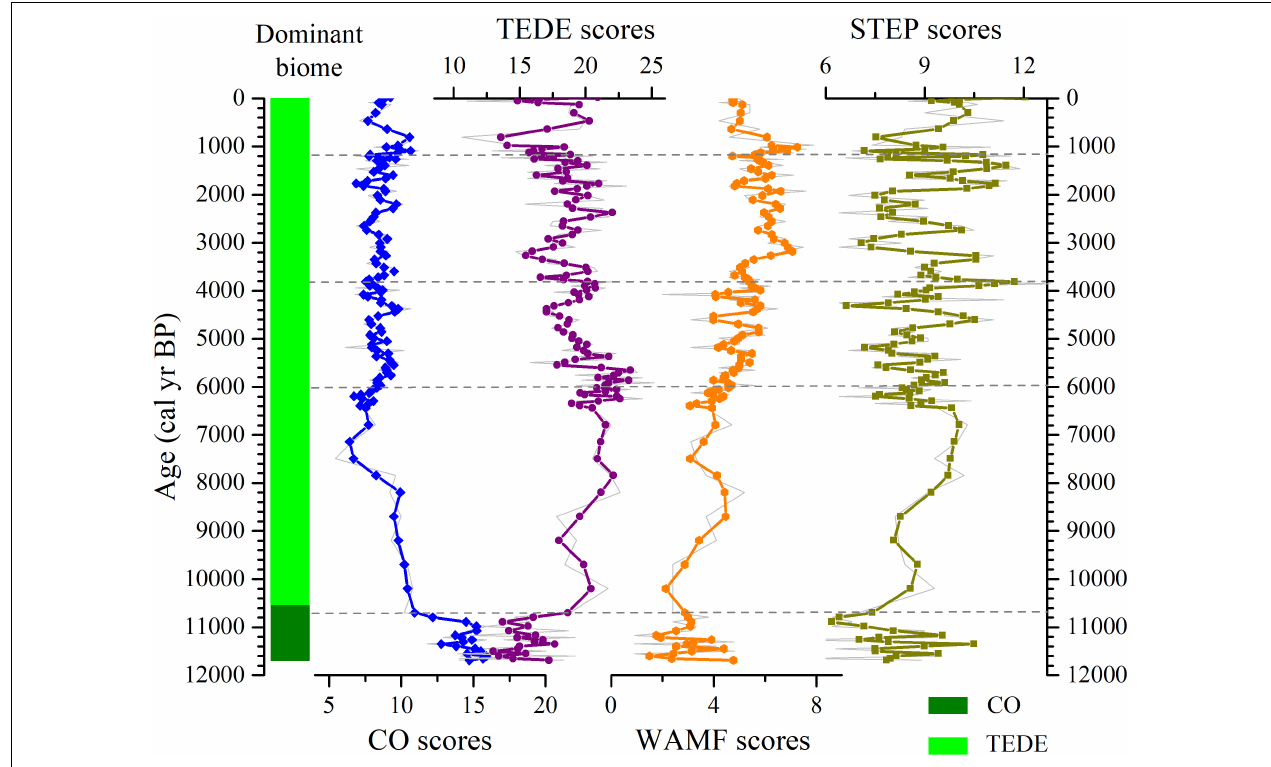
FIGURE 4 | Biome scores for the Holocene pollen record from Daye Lake. The gray curve represents biome changes based on the original scores, and the colored lines are a 5-point smoothing data. Blue curve: coniferous forest (CO); purple curve: temperate deciduous broadleaf forest (TEDE); orange curve: warm mixed forest (WAMF); yellowish-green curve: steppe (STEP). And dominant biomes are also